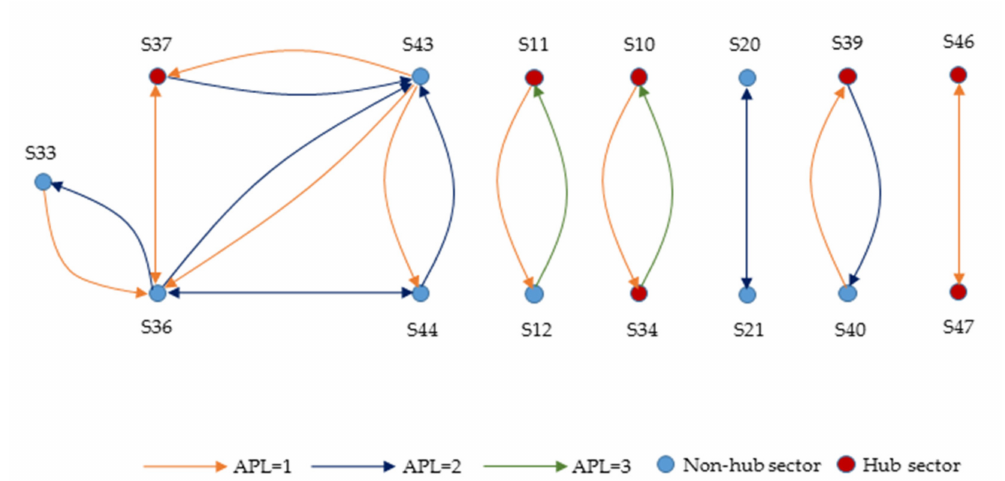
Figure 3. The hub wastewater propagation chains that APL-HCG selected in 2012. The orange, dark blue and green edges mean that their APL value is 1, 2 and 3, respectively. Each vertex in figures represents a sector explained in Appendix B. Dark red nodes indicate sectors that densely surround many linkages with a considerable degree of closeness to their linked sectors. The blue nodes imply that there are no surrounding dense linkages in the